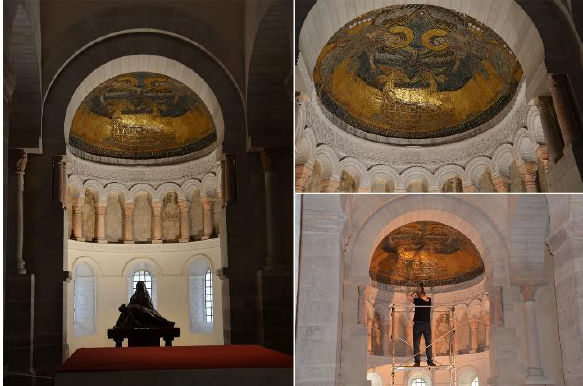
Figure 1 The mosaic of Germigny-des-prés © Line Van Wersch Composed of tesserae from different materials, sizes and periods,